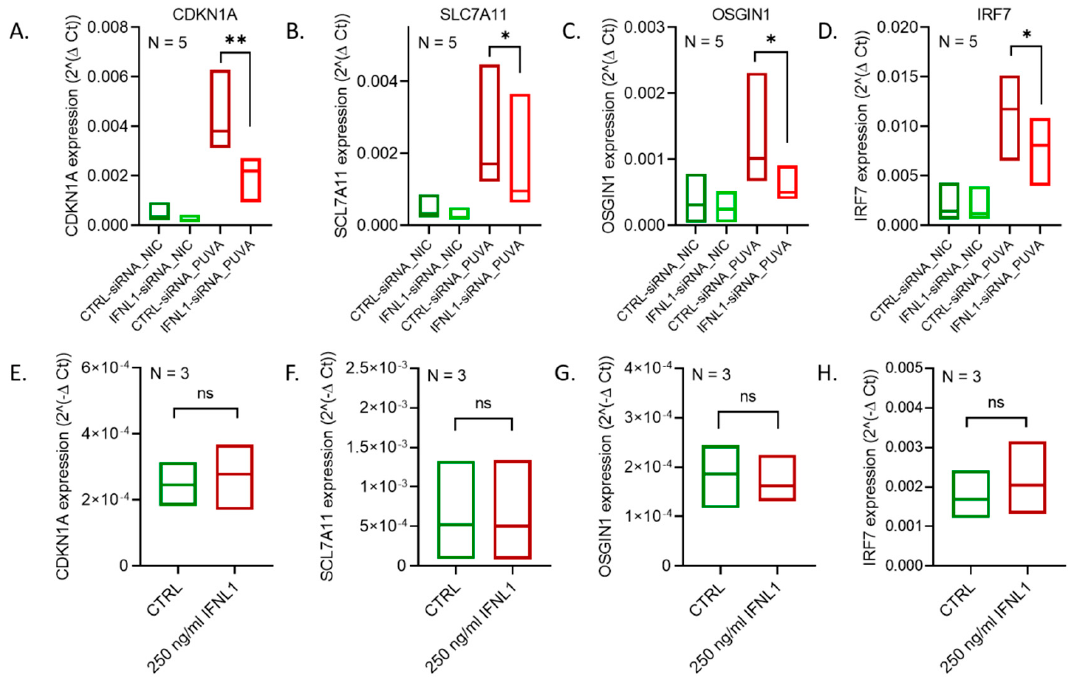
Figure 6. Expression of several of the potential hits remains under the control of IFNL1. Downregulation of IFNL1 abrogates the expression of CDKN1A, OSGIN1, SCL7A11 and IRF7 in response to 8–MOP + UVA. Hut78 cells were transfected with IFNL1-siRNA and, subsequently, treated with 8–MOP + UVA, and expression levels of the following genes were measured by RT-qPCR. ( A ) CDKN1A , ( B ) SCL7A11 , ( C ) OSGIN1 and ( D ) IRF7 . Statistics: normal distribution, paired t -test: ( A , D ) and skewed distribution, paired Wilcoxon: (B,C). Choice of the statistical test was made based on the type of data distribution (see Methods). IFNL1 knockdown efficiency: 80%. Expression of ( E ) CDKN1A , ( F ) SCL7A11 , ( G ) OSGIN1 and ( H ) IRF7 after treatment with soluble IFNL1 in the absence of DNA damage. Statistics: paired t -test. * p < 0.1, ** p < 0.05, ns – not significant.